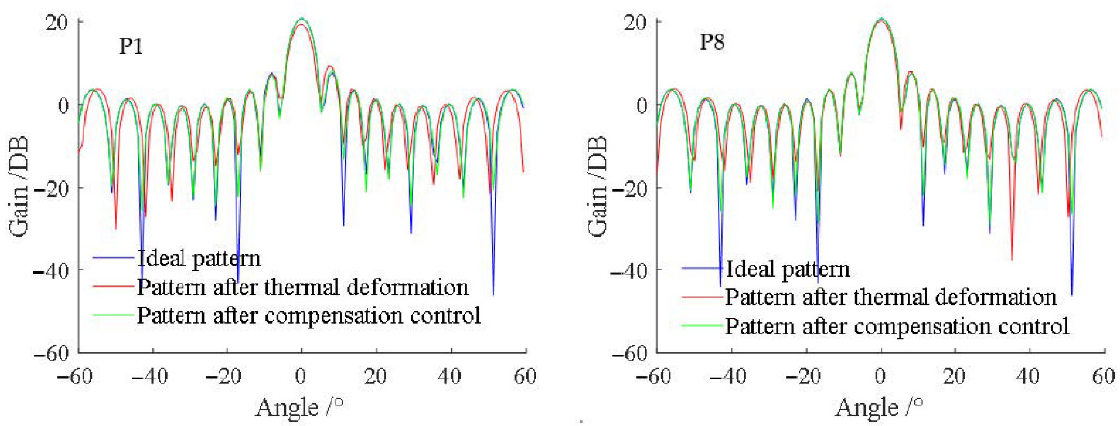
Figure 8. Patterns of the PAA ( ϕ = 0 ◦ , θ = − 60 ◦ to 60 ◦ ).